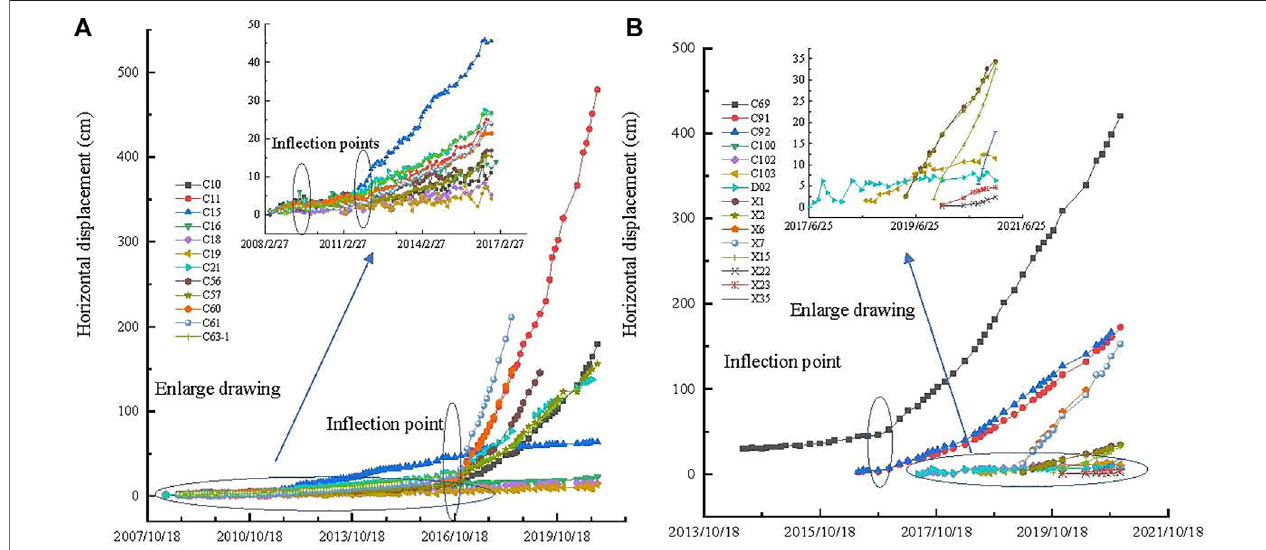
FIGURE 6 | Horizontal displacement – time curves (A) With two and three in fl ection points. (B) With one in fl ection point.